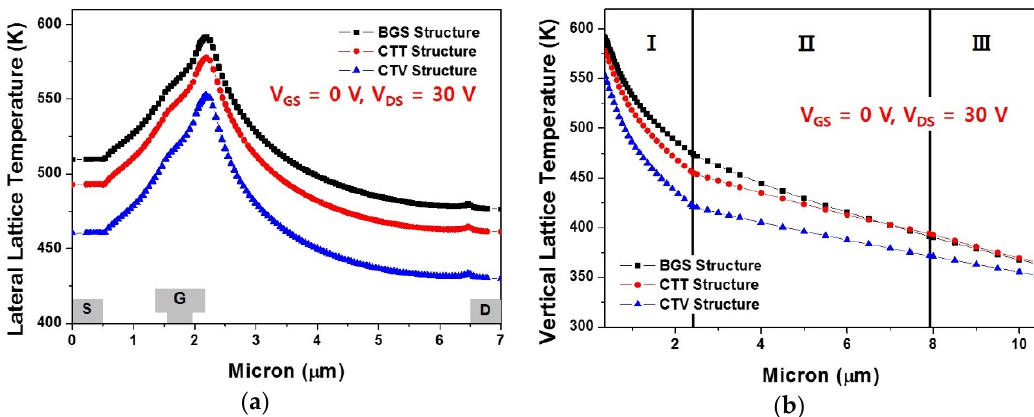
Figure 8. Comparison of the lattice temperature for the BGS, CTT, and CTV structures when V GS = 0 V and V DS = 30 V: ( a ) lateral lattice temperature in the two-dimensional electron gas (2-DEG) channel and ( b ) vertical lattice temperature near the drain-side gate head edge at the point with the highest lateral lattice temperature.